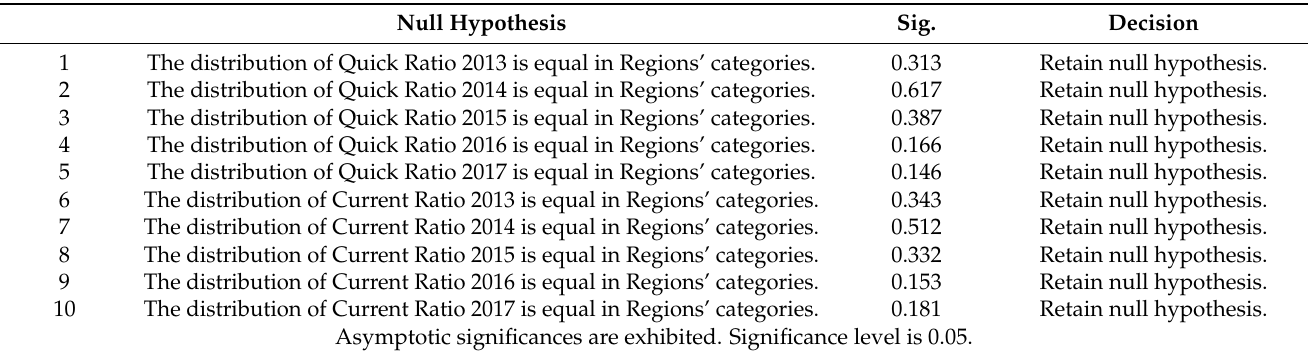
Table 9. Results of non-parametric Kruskal–Wallis test to verify if regions’ medians present equal distribution. Null Hypothesis Sig.